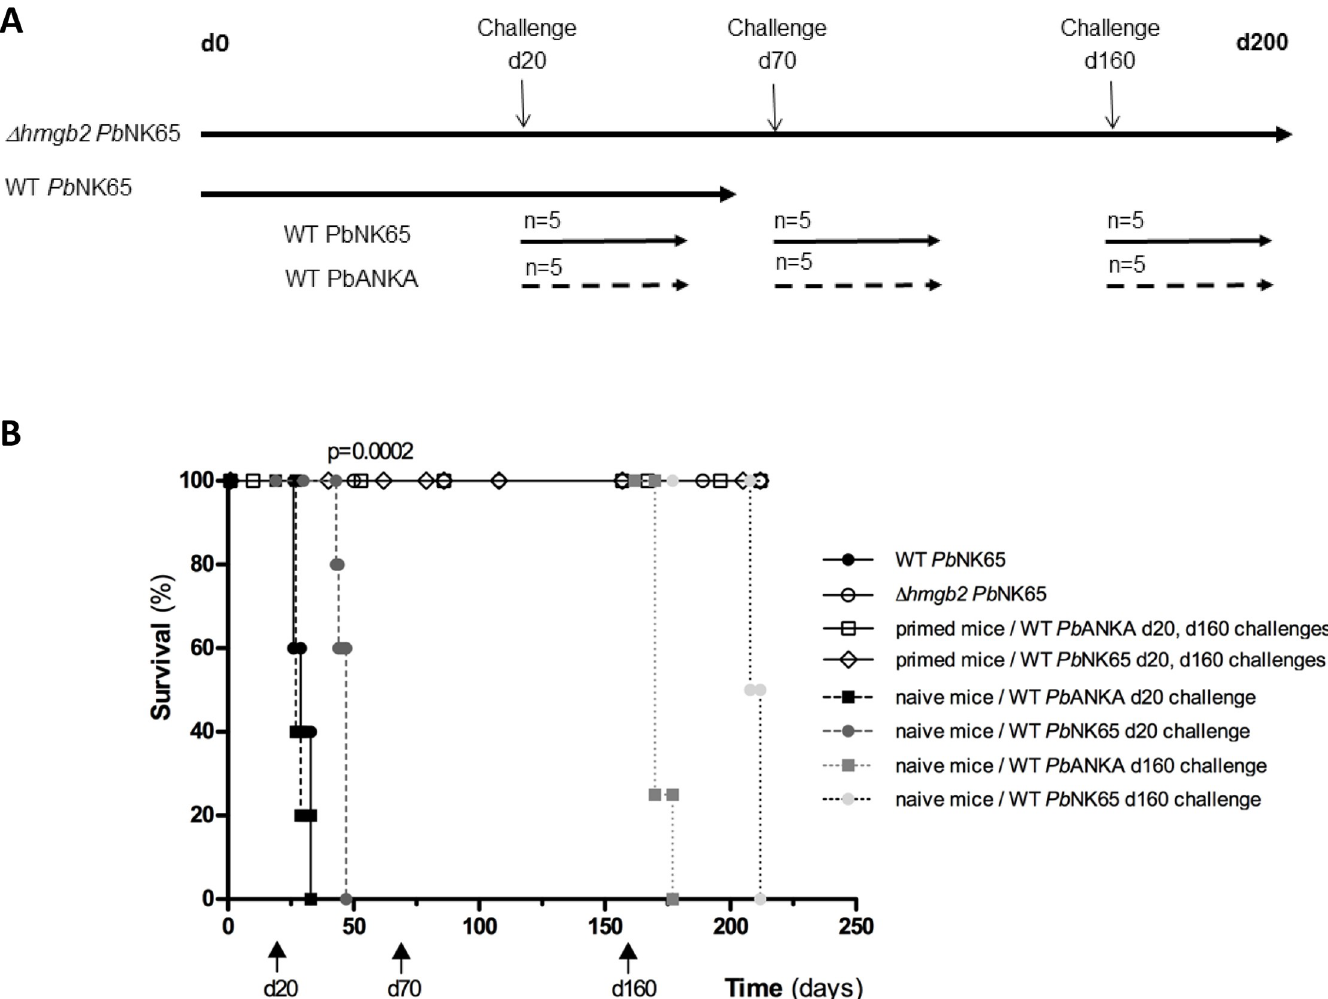
Fig 2. Long sterile protection triggered by Δ hmgb2 Pb NK65 priming against both pathogenic parasites. A. Cartoon of the experimental process. Mice (6 weeks old) were either primed with 10 5 Δ hmgb2 Pb NK65 iRBC or not. At d20, d70 and d160 post-priming the mice were infected with either WT Pb NK65 or WT Pb ANKA. B. Survival of primed hmgb2 Pb NK65 mice (n = 5) challenged subsequently at d20, d70 (not presented for simplification) and d160 (arrow) post–priming with the two highly pathogenic parasites WT Pb NK65 or WT Pb NK65 was monitored. Also, as previously stated survival of naive mice (n = 5 was analysed at d20, d70 (not presented) and d160 after infection with WT Pb NK65 and WT Pb ANKA as a control of the pathogenicity of both WT parasites. The symbols are presented in the right part of the